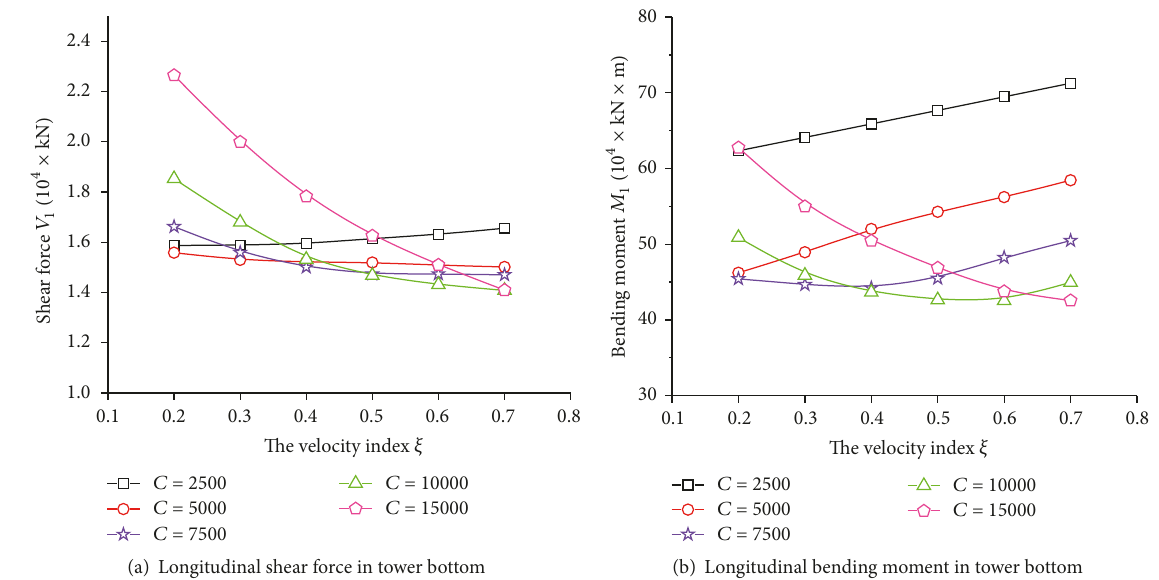
Figure 4: Change of controlled internal force in the south tower bottom with damping parameters.